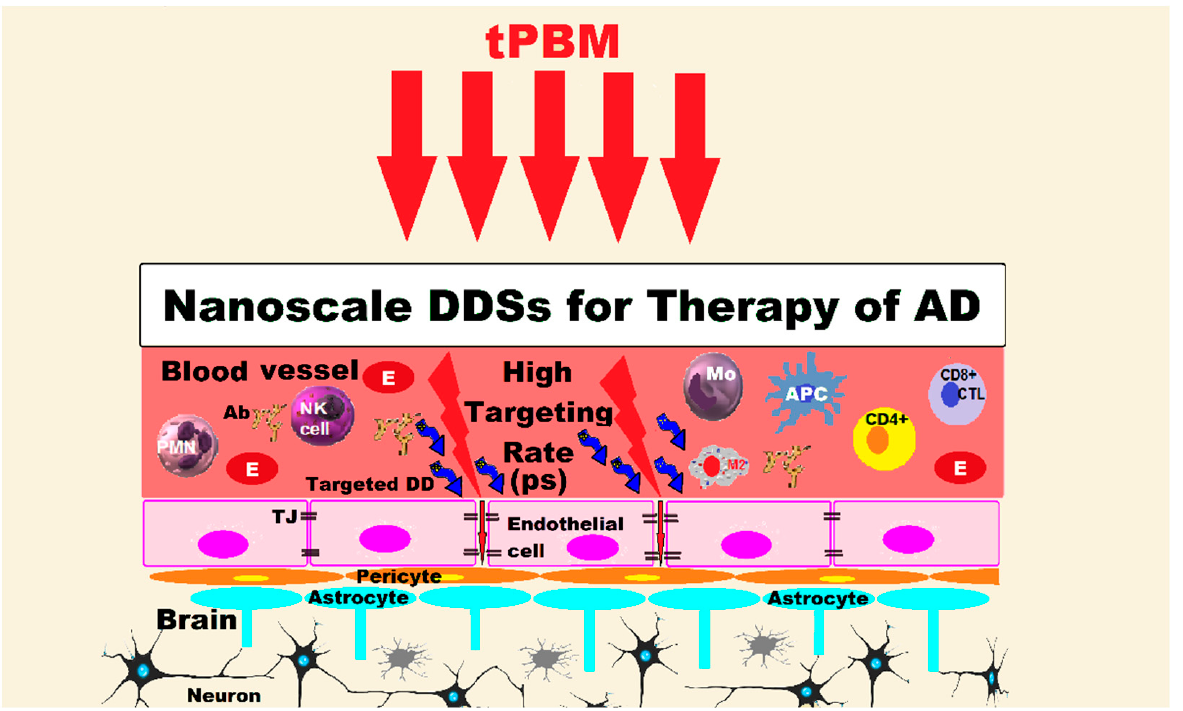
Figure 3. Breaking the BBB: future innovations with picosecond laser excitation and nanoscale DDSs in AD. Legend: Ab = Antibody; APC = Antigen presenting cell; DD = Drug delivery; DDSs = Drug delivery systems; CD4+ = CD4+ T lymphocytes; CD8+ = CD8+ T lymphocytes; E = Erythrocyte; ps = Picosecond; PMN = Polymorphonuclear neutrophil; M2 = Activated or healing macrophage of the M2 type; Mo = Monocyte; NK cell = Natural Killer cell; TJ = Tight junction; tPBM = Transcranial PBM. ↓↓ = Direction of paracellular transport. [Figure 3 was imagined and drawn by L.M.A. using Microsoft Paint 3D for Windows 10 and using completely free picture material (Open— Human Brain Png) from SeekPNG.com (accessed on 27 February 2023), for which we are very grateful].